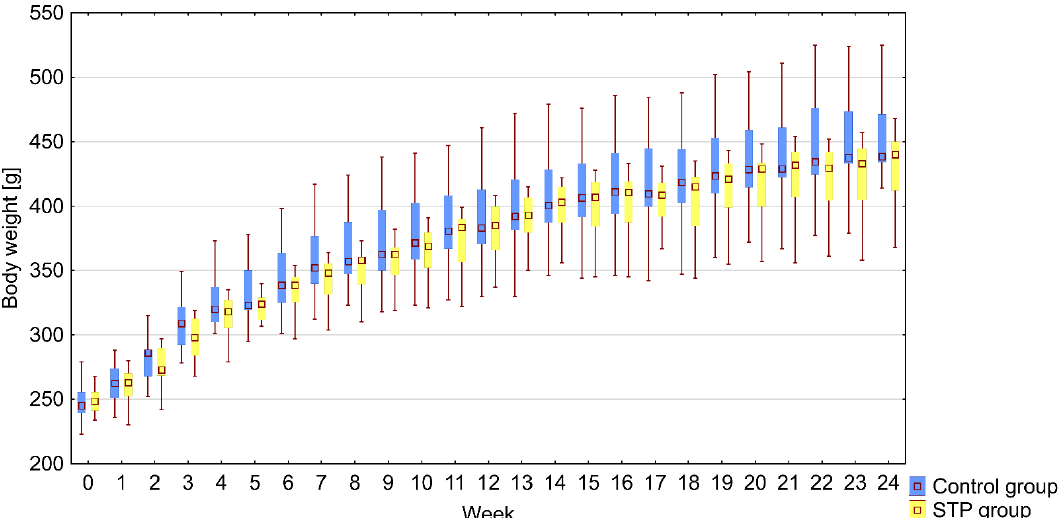
Figure 1. The effect of administration of stiripentol on body weight in rats. Results presented as follows: median (lower quartile—upper quartile).